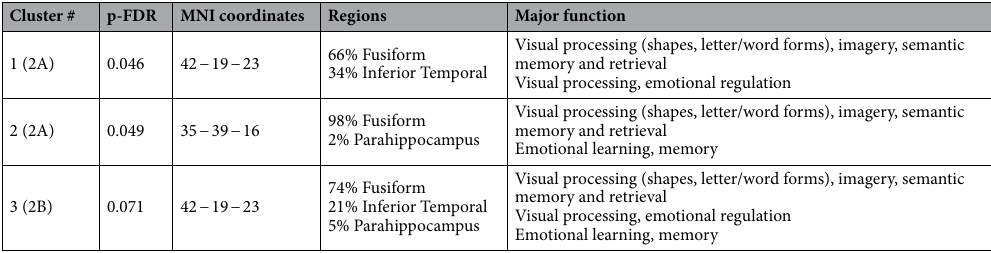
Cluster # Table 3. Details of significant clusters from Fig. 2 Corrected p -value, location, atlas labels and major function of clusters with lower sulcal depth (SD) correlated with higher ScreenQ scores controlling for child sex and age, shown in Fig. 2A and also controlling for maternal education shown in Fig. 2B (thresholds: two-sided p-FDR < 0.05 for 2A and p-FDR < 0.10 for 2B). MNI coordinates are left–right, posterior-anterior and inferior- superior relative to the anterior commissure. Regions indicates the percentage of each cluster residing in the respective Desikan-Killiany DK40 atlas-defined area.